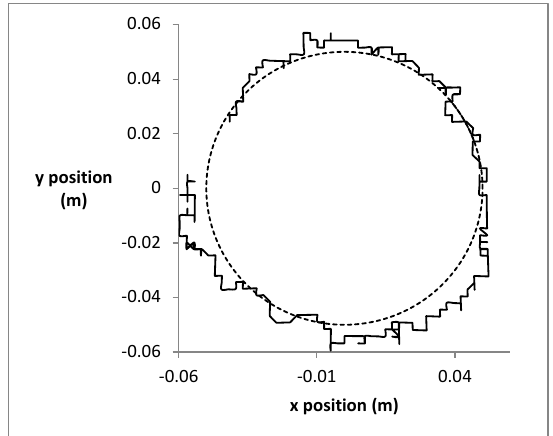
Figure 32: Circular trajectory tracking ball position Figure 31. Circular trajectory tracking ball